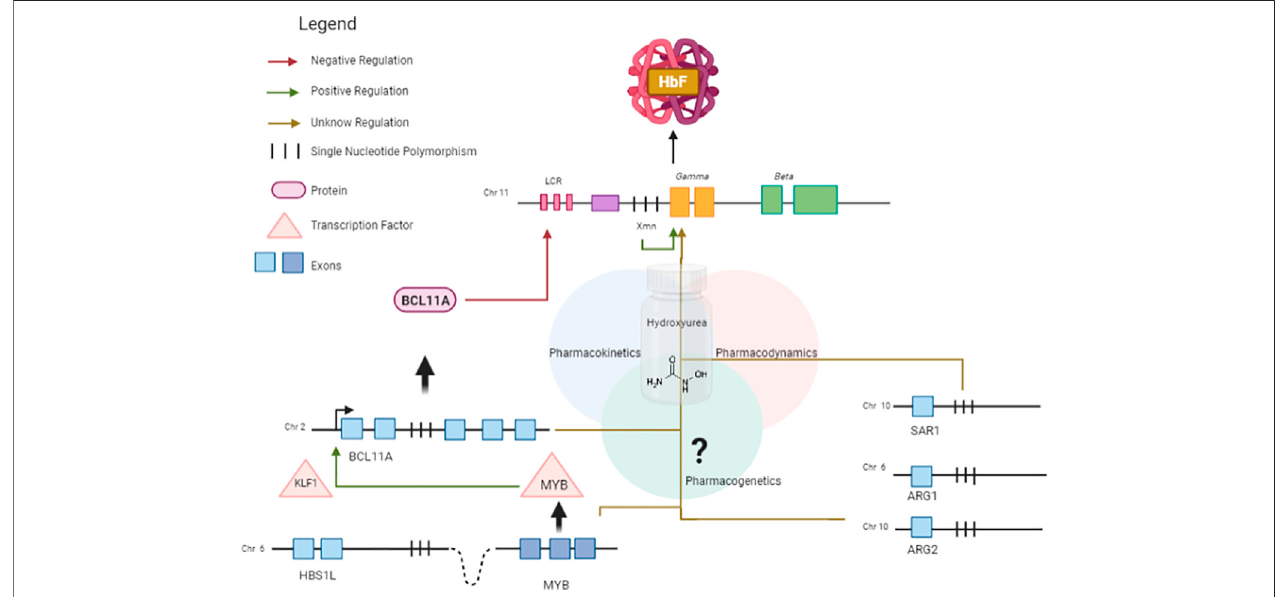
FIGURE 4 | Schematic diagram showing HbF regulation in response to HU, an HbF-inducing drug. BCL11A is a master repressor of gamma genes. The erythroid transcription factor KLF1 activates the transcription of BCL11A by binding to its promoter region. The expression of KLF1 is possibly regulated by MYB. The HBS1L- MYB intergenic region contains several trait-associated common genetic variations and a distal enhancer of MYB , promoting long-range transcription regulation by chromatin looping. SAR1A encodes a GTP-binding protein which has been reported to be associated with γ -globin expression. Variations in the candidate genes ARG1 and ARG2 are associated with HbF changes. Pharmacokinetic genes can affect absorption, distribution, and metabolism of